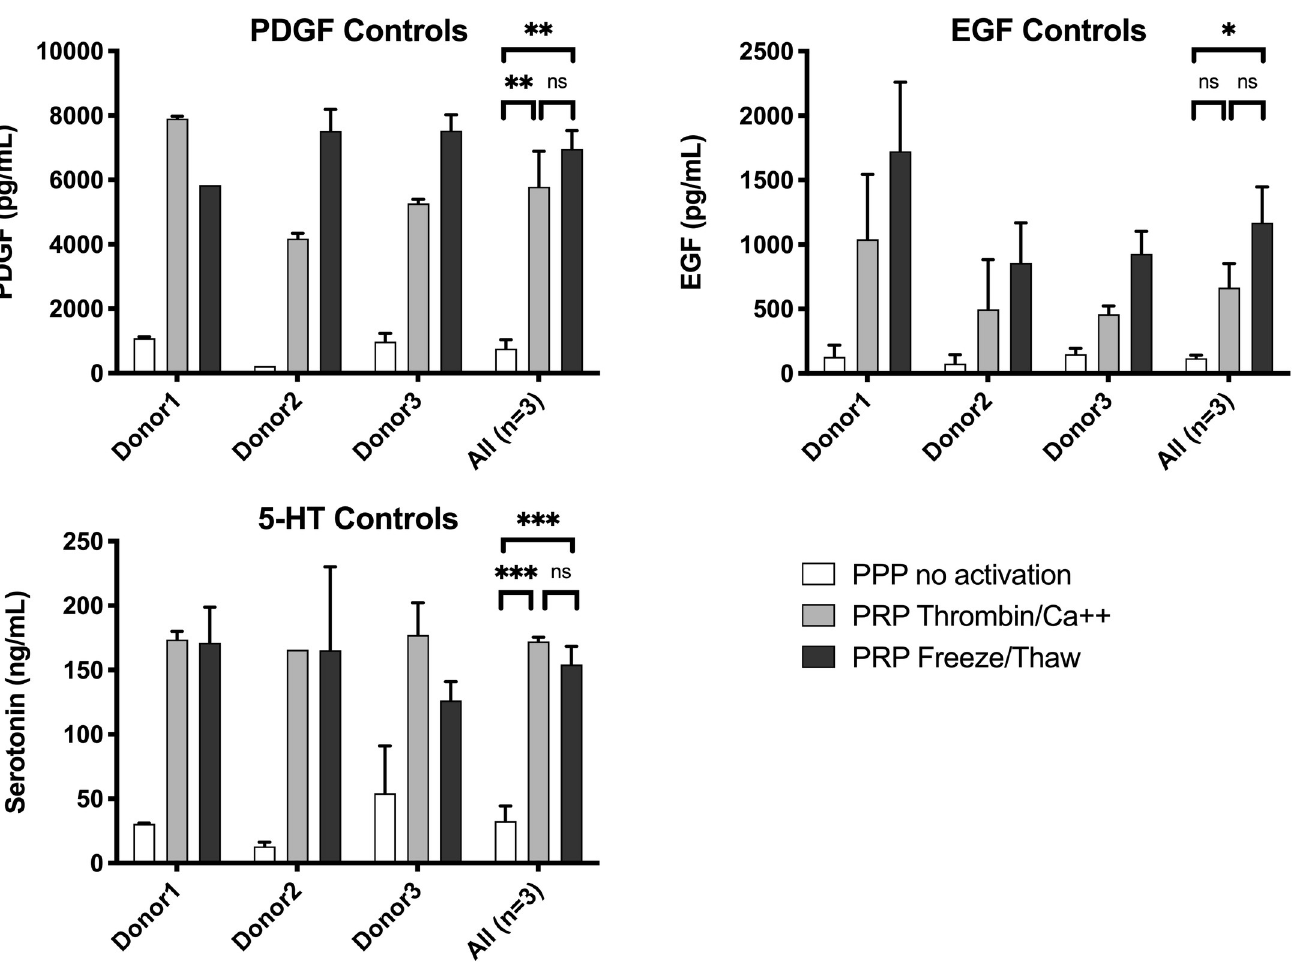
Fig 5. PDGF, EGF, and 5-HT in supernatants of control samples: Negative controls (no activation) and positive controls (thrombin activation and freeze / thaw). Results are means ± SEM, n = 3. Abbreviations: EGF, epidermal growth factor; Hgb, hemoglobin; PDGF, platelet-derived growth factor. Asterisks indicate significant differences in the amount of PDGF, EGF and 5-HT in the supernatants of un-activated, thrombin/Ca++ activated or freeze/thaw treated PRP. � p < 0.05, �� < 0.01, ��� < 0.001 by ANOVA with Tukey’s multiple comparisons test adjusted for multiplicity.